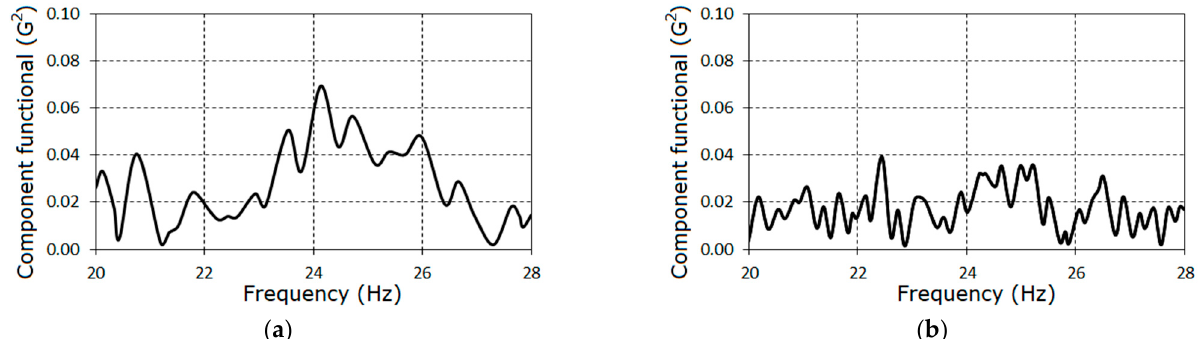
Figure 14. The first ( a ) and the second ( b ) component variance functionals for the first stage.